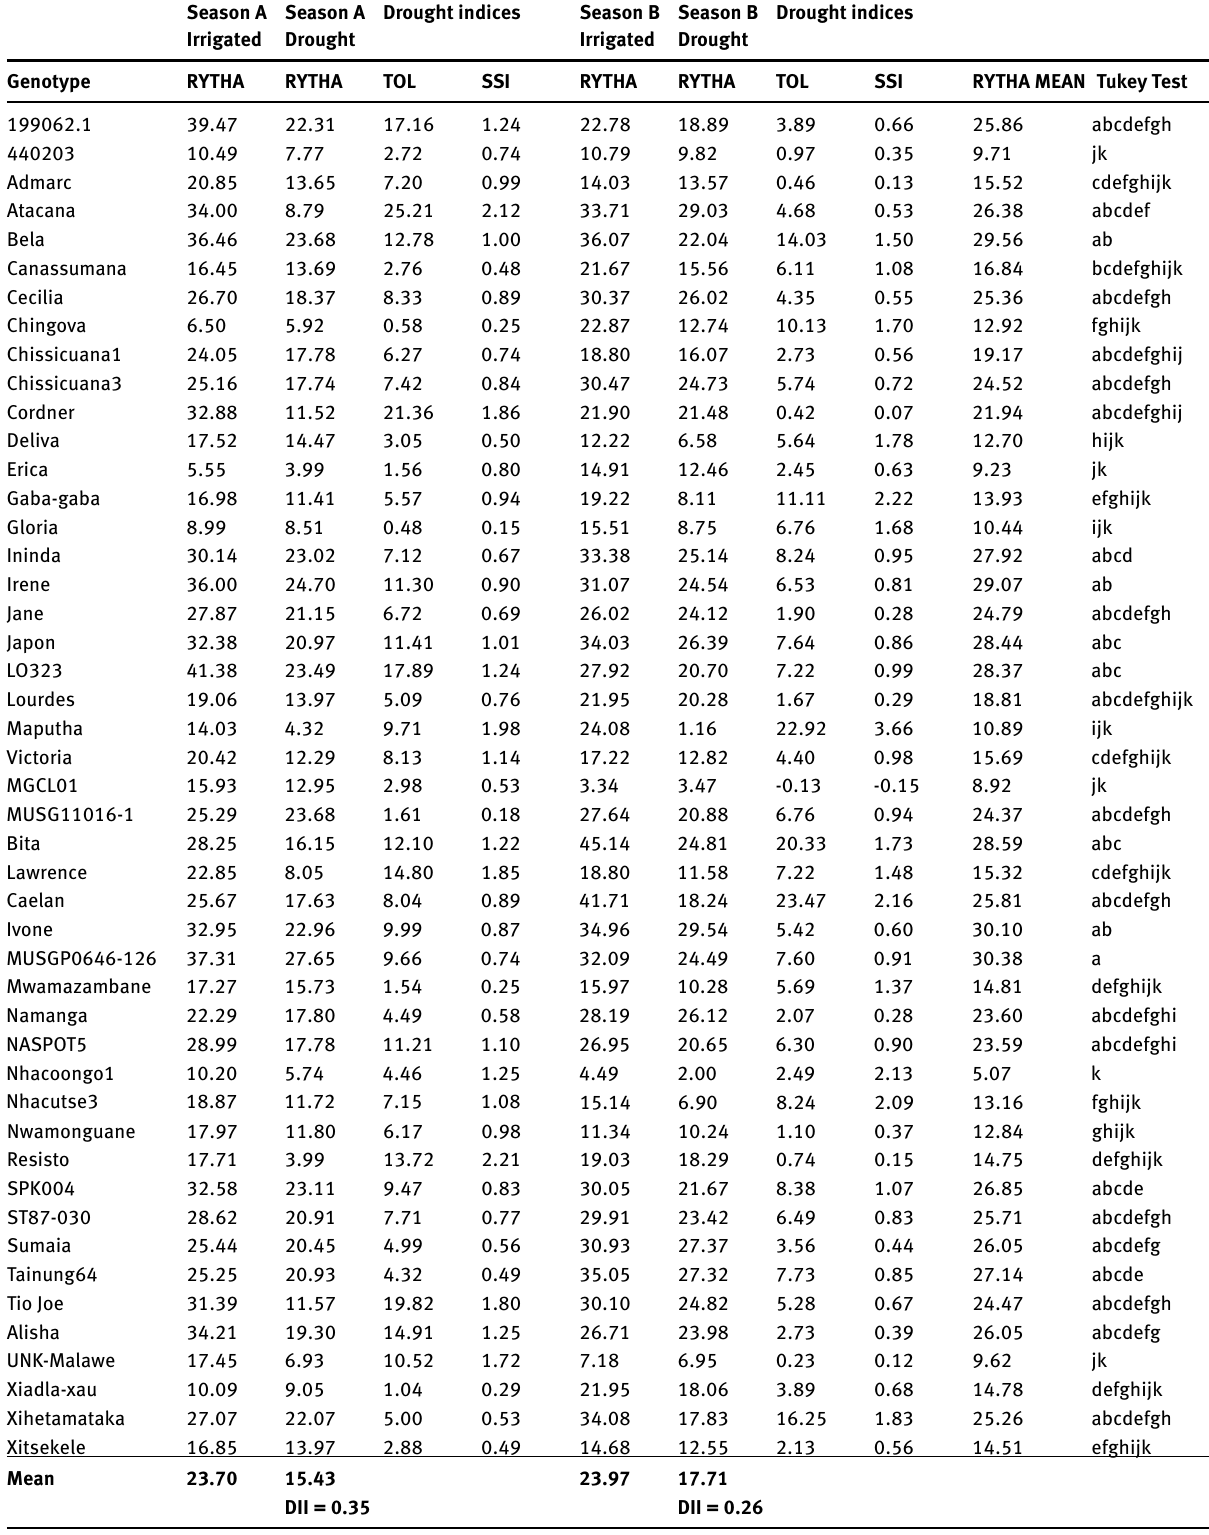
Table 2: Drought indices and storage root yield (t/ha) of genotypes in well-watered (irrigated) and water deficit (drought) treatments over two seasons of testing at Umbeluzi Research Station,